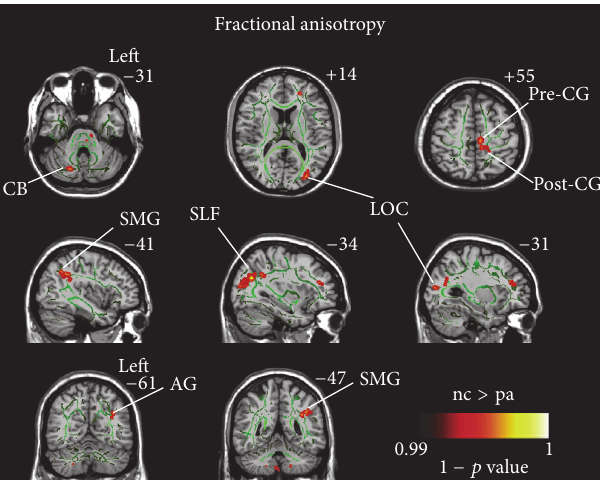
Figure 1: Differences in fractional anisotropy (FA) between the SCI patients and healthy controls based on tract-based spatial statistics (TBSS) ( 𝑝 < 0.01 , corrected using threshold-free cluster enhancement). Hot color represents 1 − 𝑝 values. It is overlaid on the gyrus skeleton (green) and the MNI 152 template. Significant decreases in FA following SCI occurred in the left angular gyrus (AG), right cerebellar (CB), left precentral gyrus (PreCG), left lateral occipital region (LOC), left superior longitudinal fasciculus (SLF), left supramarginal gyrus (SMG), and left postcentral gyrus (PostCG).